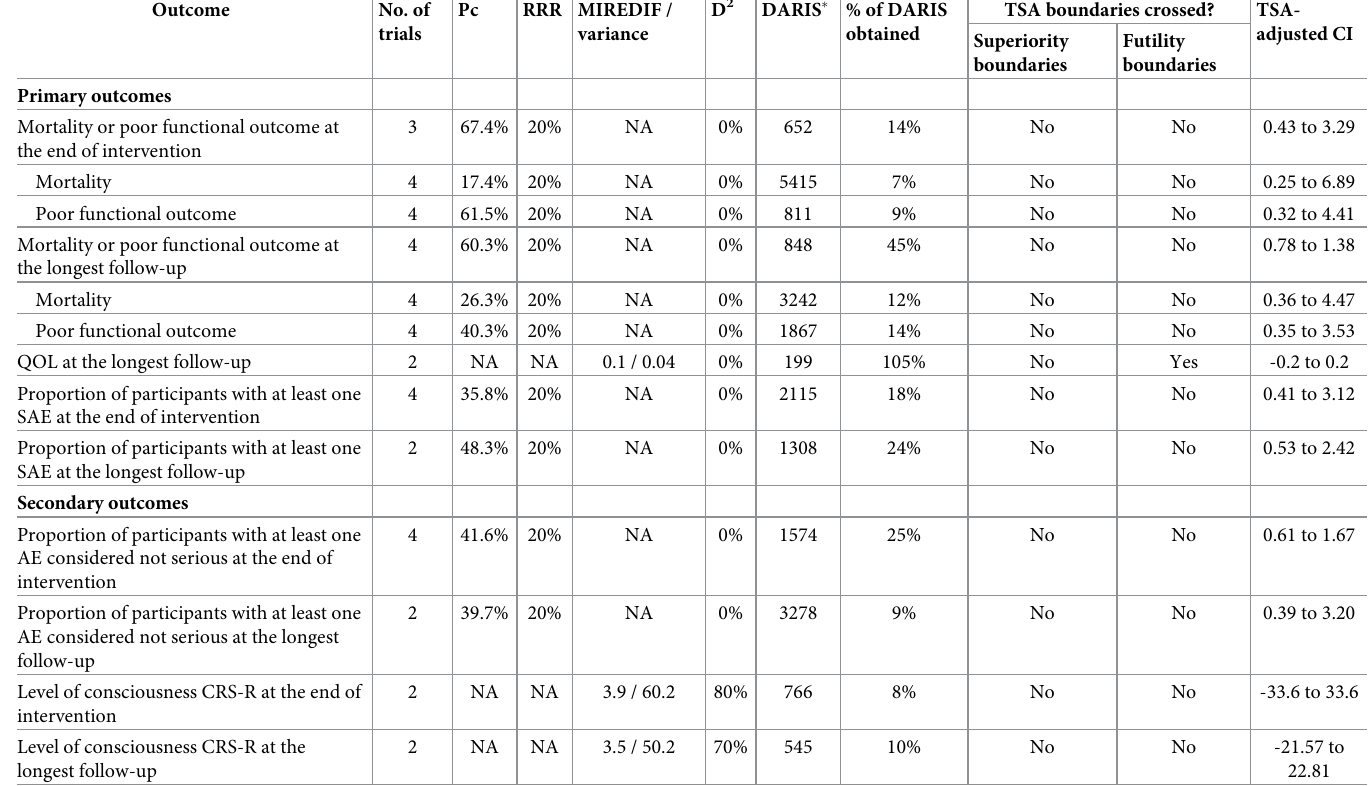
Table 2. Results of trial sequential analysis of early mobilisation versus standard